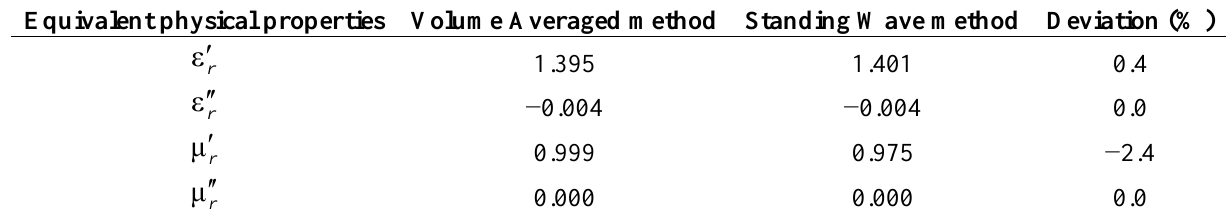
Table 3. Equivalent physical properties of particle-shaped water (water, volume rate: 10%).